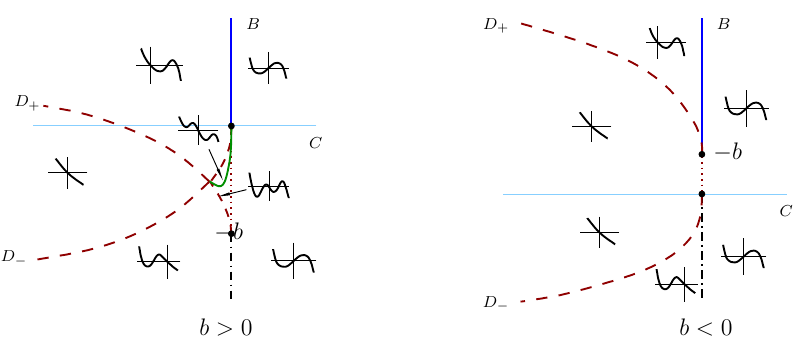
Figure 31 . Detailed structure of the potential for Case III: A < 0 , A + a < 0 . Refer to the caption of figure 24 for details on the various marked lines.